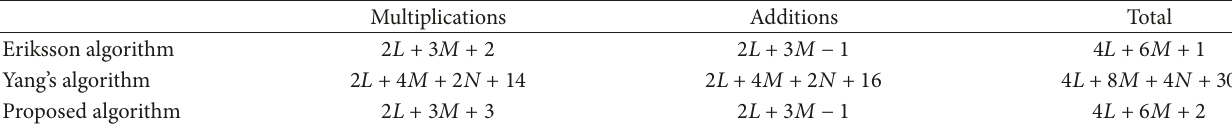
Table 1: Computational complexity.